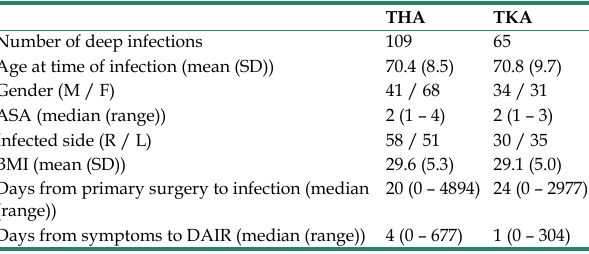
Table 1. Demographic data of 174 patients with a deep prosthetic joint infection after THA or